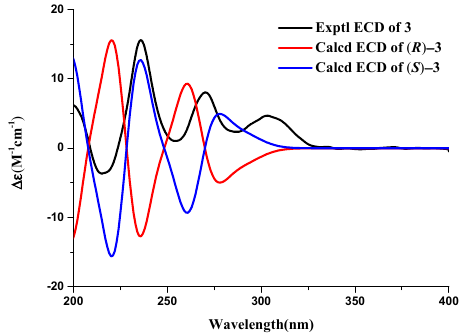
Figure 8. Calculated and experimental ECD spectra of compound 3.